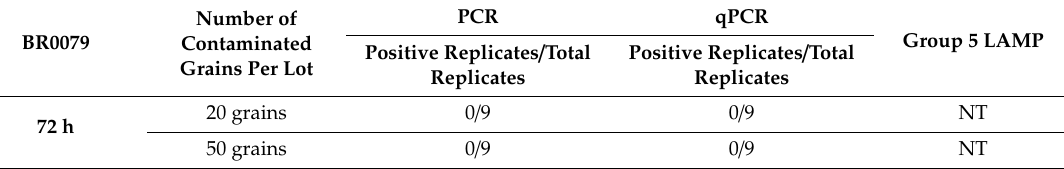
Table 3. Sensitivity of the PCR (C45 primers), qPCR (C45 primers), and LAMP (group 5 primers) tests in seed matrix contaminated with a non-target P. oryzae strain from E. indica